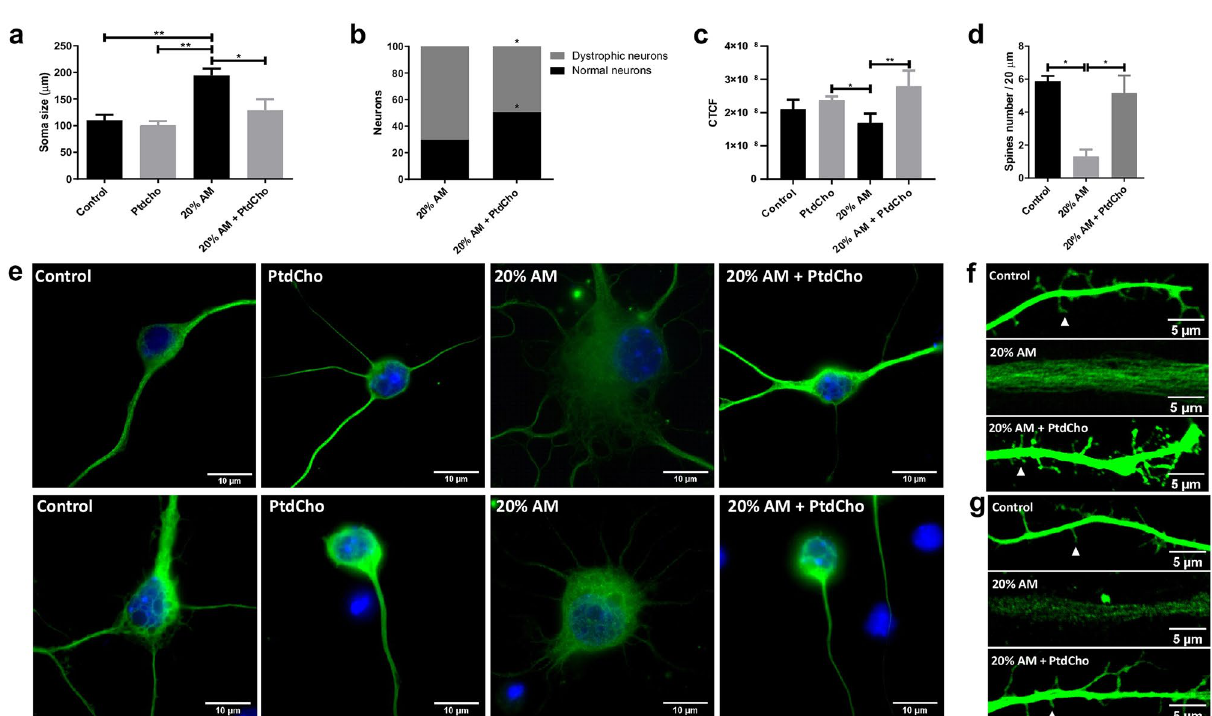
Figure 4. PtdCho rescues neuronal function induced by AM. ( a ) Quantification of neuron’s soma of cells incubated under the indicated condition. Graph represents the area of neuronal soma measured in four independent experiments. Data were presented as mean ± SEM. **p < 0.01; *p < 0.05. ( b ) Percentage of normal neurons (black bars) and dystrophic neurons (grey bars) after 3 days in culture under the indicated conditions *p < 0.05 (Student’s T-test). ( c ) βIII-tubulin signal expressed as corrected total cell fluorescence (CTCF). ( d ) Quantification of spine number. Values of quantification are expressed as mean ± SEM, *p < 0.05. ( e ) Representative images of neurons (× 100) Scale bars: 10 μm and dendritic spines (× 63) under the indicated conditions after 3 days ( f ) and 7 days ( g ) of culture. Arrowheads indicate spine. Scale bars 5